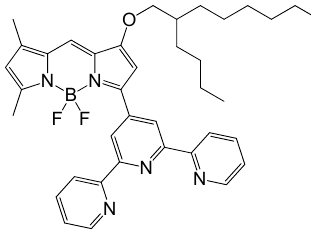
Figure 1. Chemical structure of 2,2 ′ :6 ′ ,2 ′′ -terpyridine-substituted BODIPY (BDP-TPY).